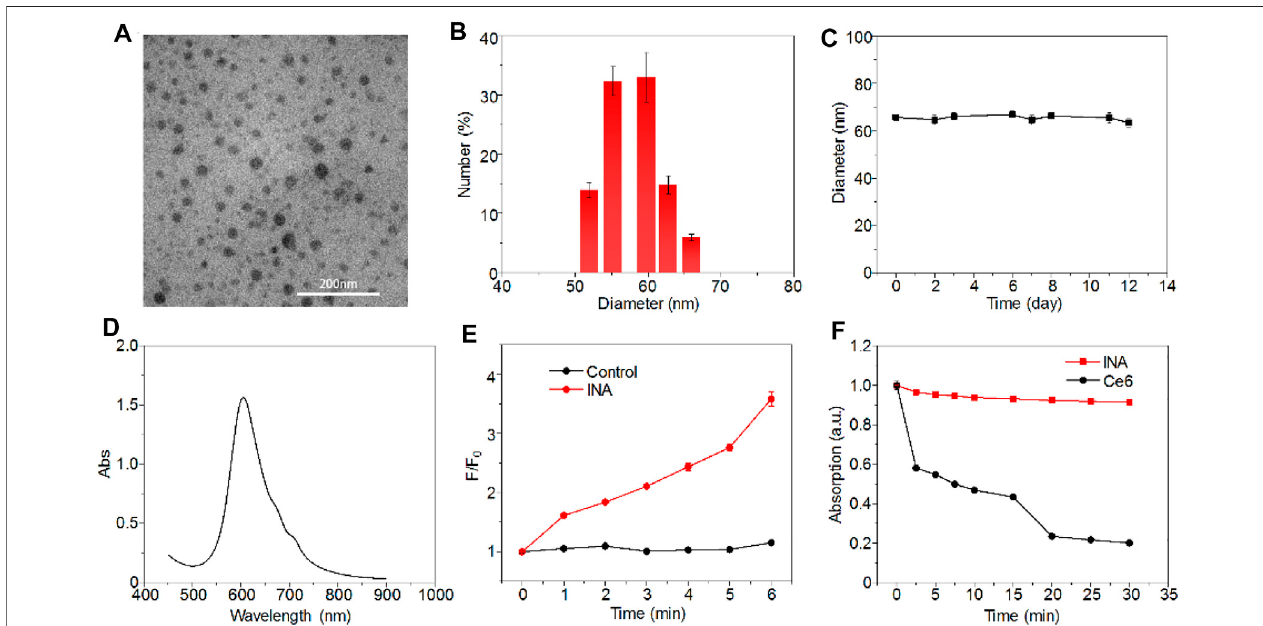
FIGURE 2 | Characterizations of INA. (A) Representative TEM image of INA. (B) Hydrodynamic size distribution of INA. (C) Average hydrodynamic size of INA is a function of storage time. (D) Absorption spectrum of INA. (E) Fluorescence intensity change (F/F 0 ) of SOSG with or without INA as a function of 635-nm laser irradiation time. (F) Normalized absorption changes of INA and phthalocyanine at 660 nm as a function of 635-nm laser irradiation time (0.1 W cm − 2 ). Error bars represent the standard deviations of three different